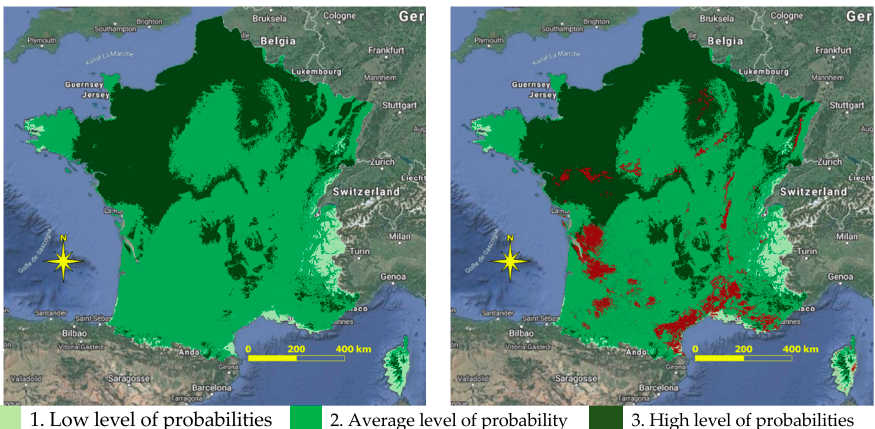
Figure 8. Potential suitable areas for grapevine crop according to RCP 4.5 climate scenario for 2070. Grapevine crops declared in 2018 are represented in red.